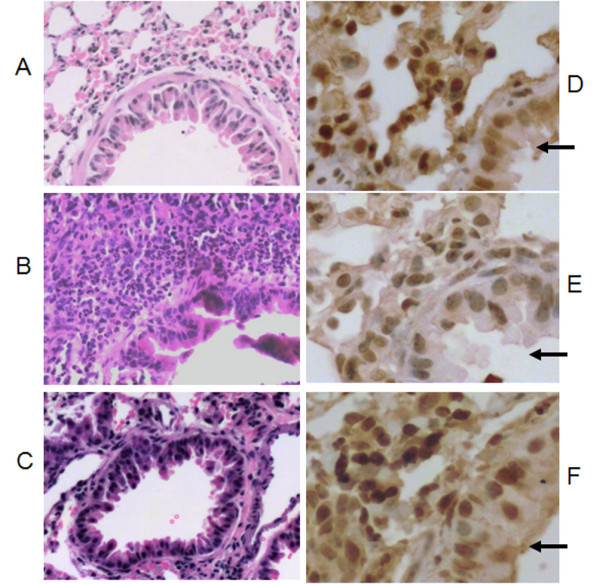
Histological evidence of airway inflammation (A-C) and PTEN expression determined by immunohistochemical staining(D-F) and the arrows pointing to the epithelia cells. (A and D): Lung tissue from mouse sensitized with saline. (B and E): Lung tissue from mouse after sensitization with OVA. (C and F): Lung tissue from mouse after sensitization with OVA, and treatment with dexamethasone.